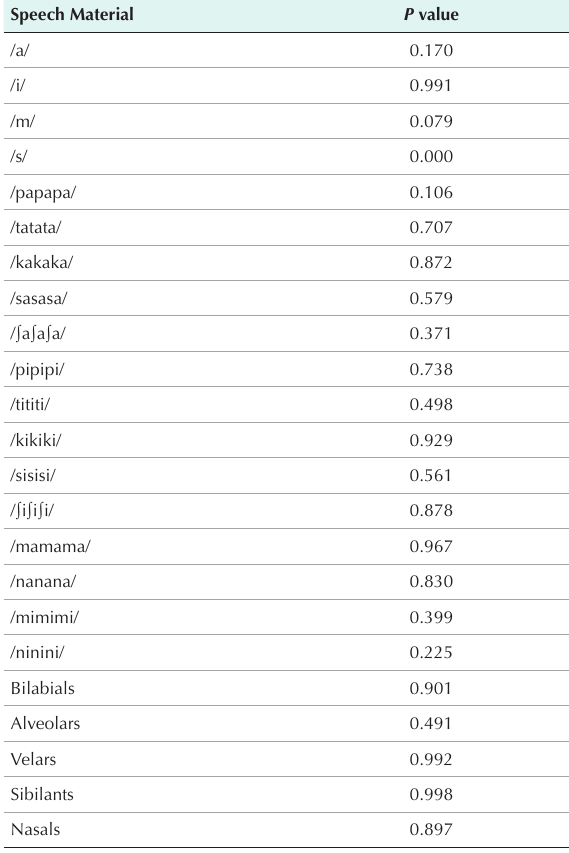
Table 2 . Comparing the Significance of Mean Nasalance Scores (%) in Different Age Groups (4, 5 and 6 years old) in Persian-Speaking